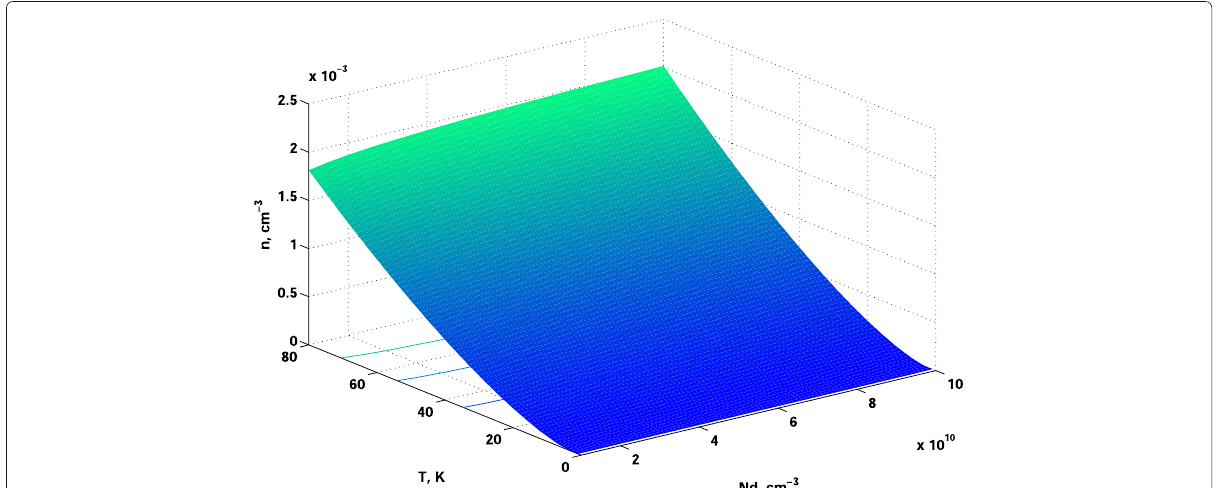
Fig. 2 Electron concentration in Si conduction band vs donor concentration N d and the temperature